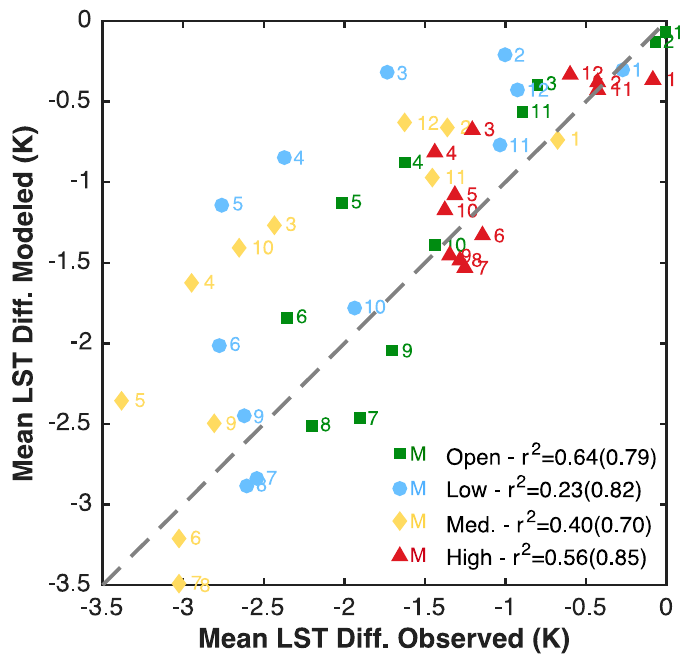
Figure 5. Mean LST differences between low and high irrigation in Landsat LST vs. modeled simulations for each month. These are calculated using the low and high irrigation areas and simulation scenarios aggregated through the study period by month similar to Figures 2 and 3. The r 2 values along the 1:1 line are shown with and without spring months (3, 4, 5) included in the calculation.